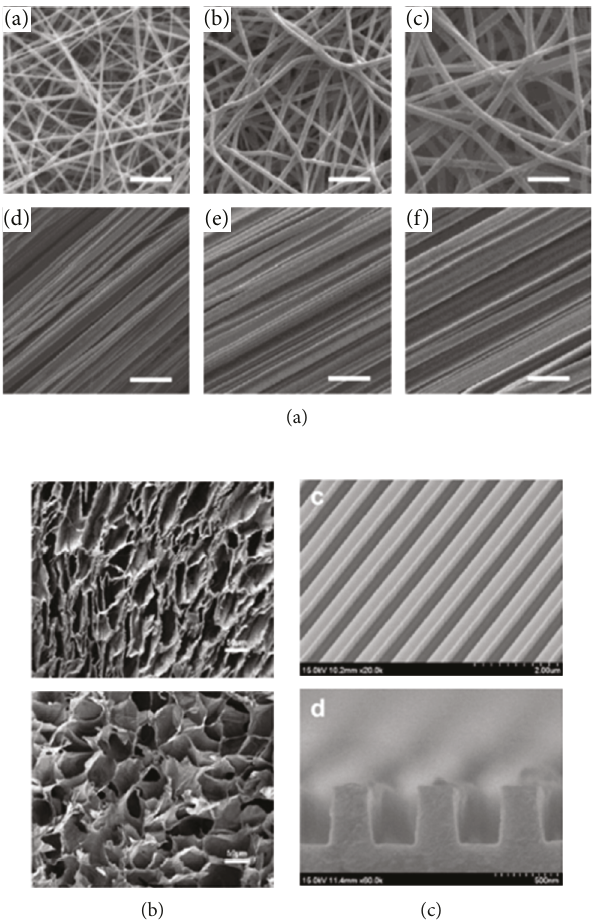
Figure 3: SEM images of di ff erent topographies used to in fl uence PSC fate. (a) Electrospun meshes with di ff erently sized fi ber diameters, in random or aligned fi ber orientation, investigated with respect to germ layer commitment [73]. (b) Rod (top) or sphere (bottom) pore-shaped sca ff old used for bone di ff erentiation. Study found spherical pores supported osteogenic fate better than rod shapes [1]. (c) Nanosize surface grooves instructed PSCS into neuronal lineage without additional inducing agents